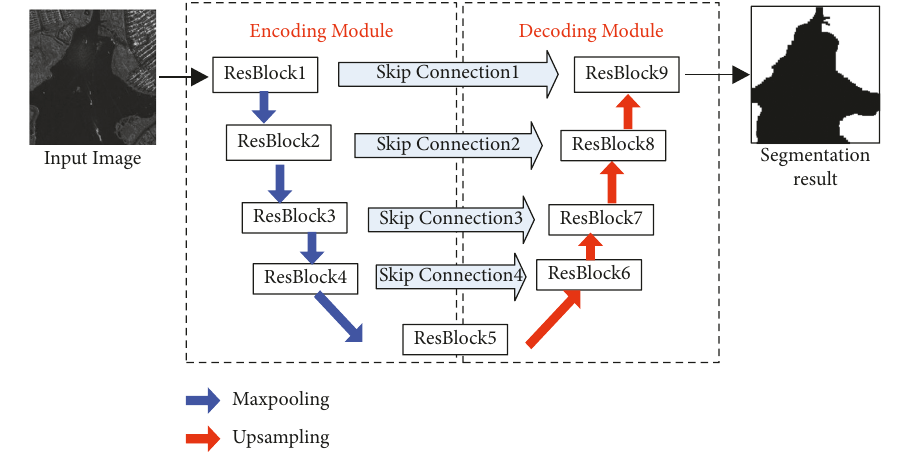
Figure 7: The network architecture of land-sea segmentation.